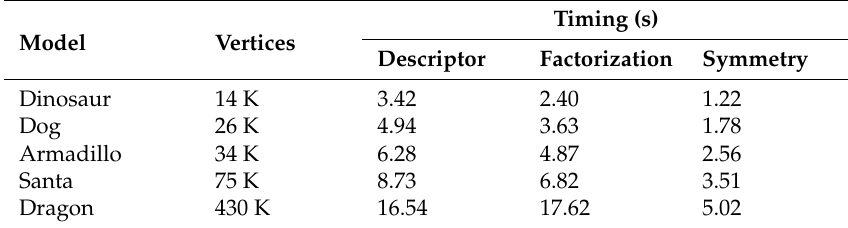
Table 1. Run Time for Each Functional Section.